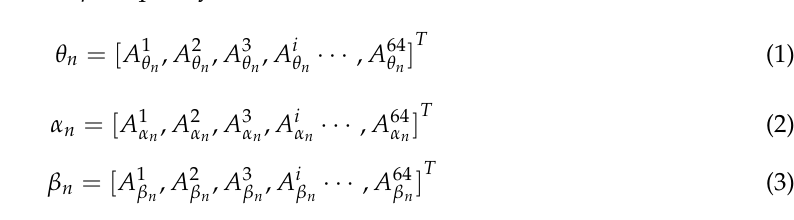
Figure 2. An overview of the approach. ( θ n , α n and β n represent the spectral maps at 4–7 Hz, 8–13 Hz, and 13–30 Hz of the No. n trail; A 1 recorded by the No. 1 channel electrode to No. 64 channel electrode at 4–7 Hz, 8–13 Hz, and 13–30 Hz of the No. n